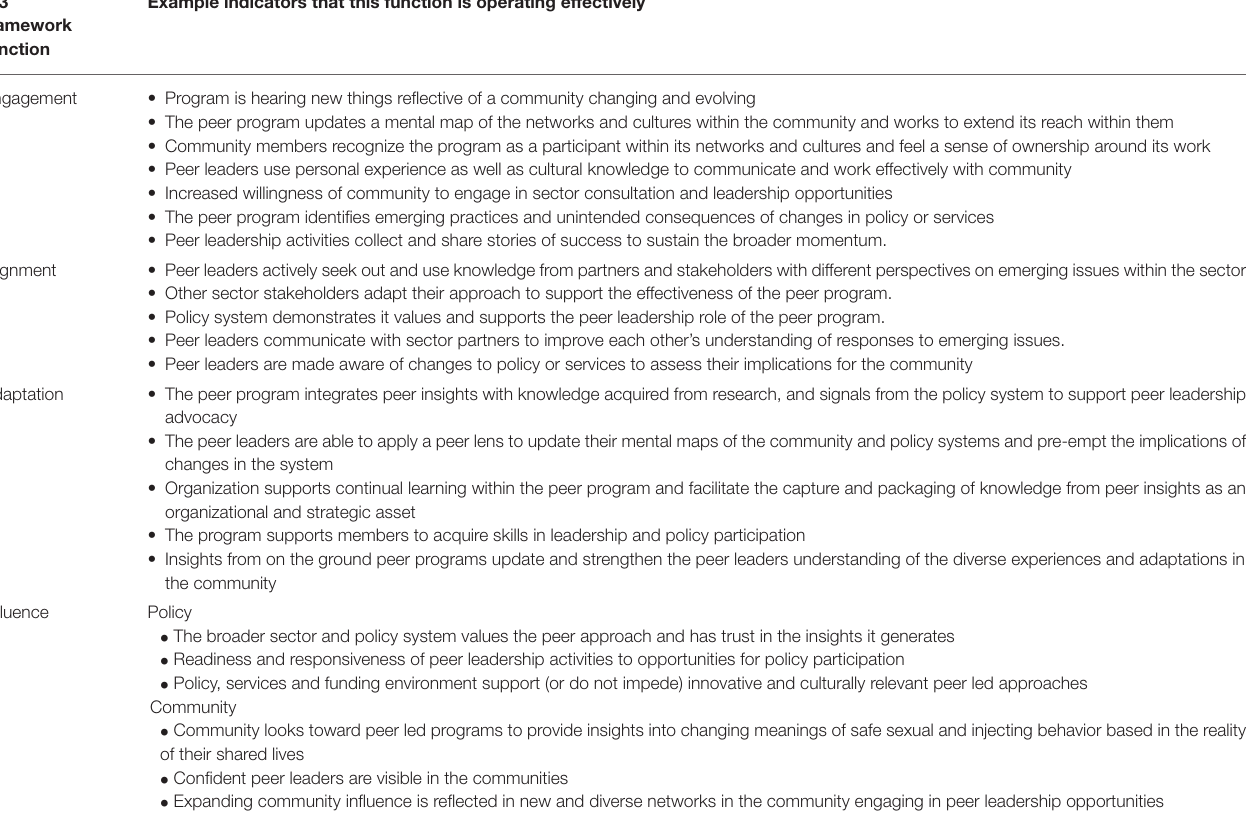
TABLE 3 | Selection of peer leadership quality and influence